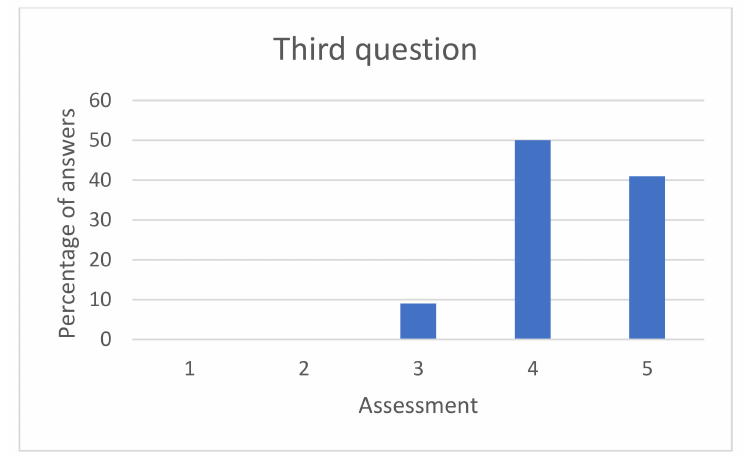
Figure A4. Results of question